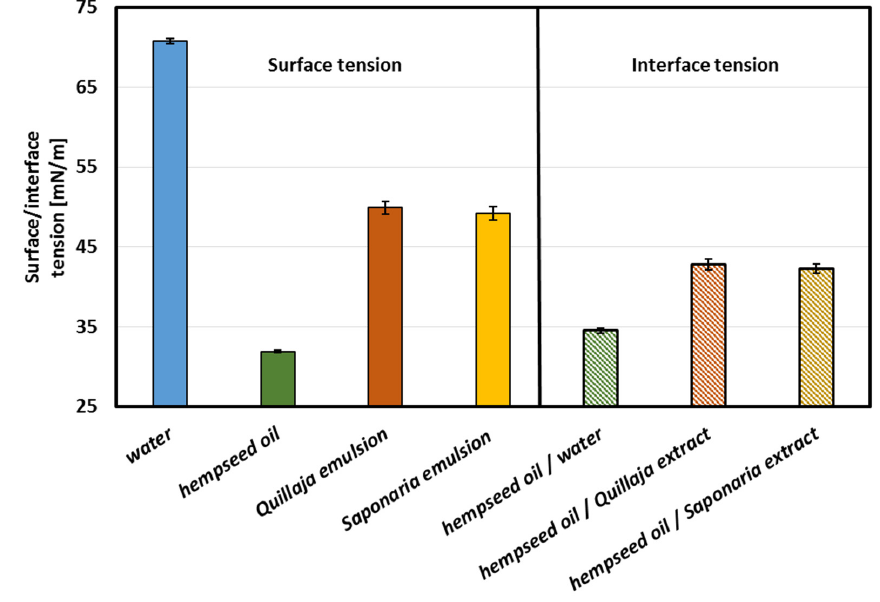
Figure 6. Surface tension of hempseed oil and water solutions of plant extracts from Saponaria officinalis and Quillaja saponaria at a concentration of 2 g/L and interface tension in the emulsion systems with and without surfactants.